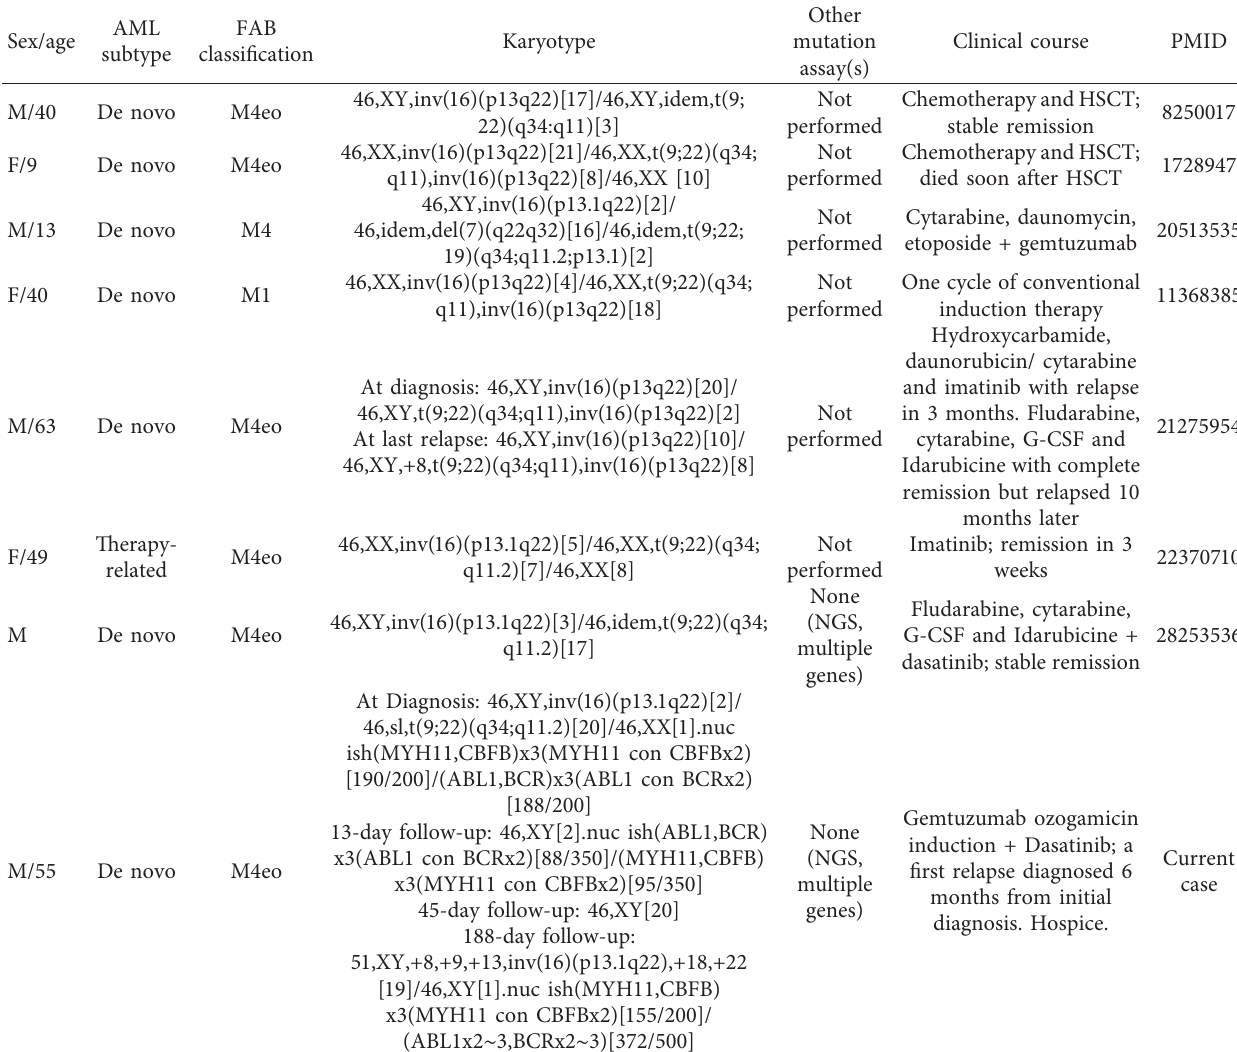
Table 1: AML cases with concurrent inv(16) and BCR-ABL genetic abnormalities in this study and selected cases from literature review.